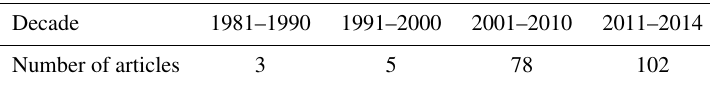
Table 1. Date range and number of articles.